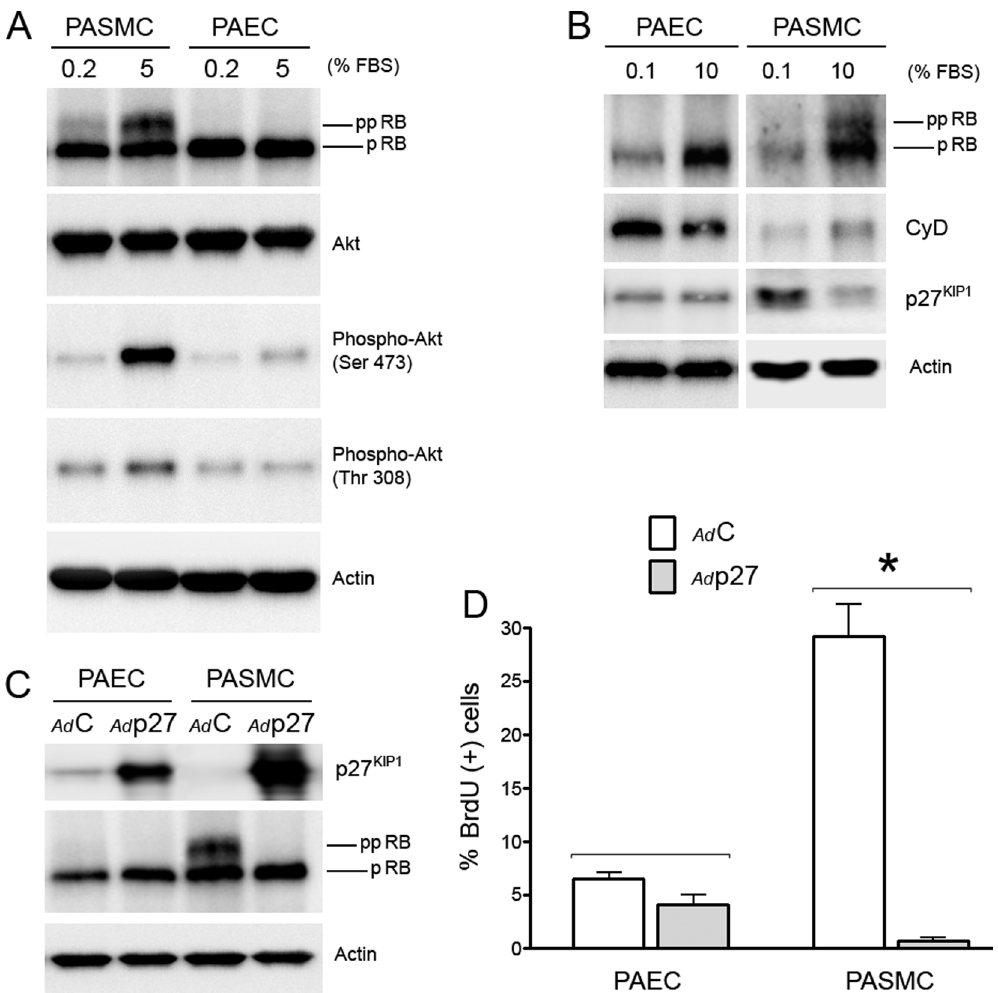
Figure 3. Increased serum phosphorylates retinoblastoma, Akt Ser473 , and AKT Thr308 and decreases p27 KIP1 in confluent PASMC, but not in confluent PAEC. A and B) Human PAEC and PASMC attained confluence in low (0.2%) serum and were maintained in low serum for seven days. Cells were then exposed to 0.2% or 5% serum and 24 hours later, cell lysates were harvested for protein analysis. Representative Western blots are shown. C) Human PAEC and PASMC attained confluence in low (0.2%) serum and were maintained in low serum for seven days. Cells were infected for 2 hours at a multiple of infectivity of 200 with a replication-deficient adenovirus serotype 5 containing either a human p27 KIP1 ( Ad p27) or alkaline phosphatase ( Ad C) cDNA driven by a CMV promoter. Cells were then exposed to 5% serum and cell lysates harvested 24 hours later. A representative Western blot is shown. [pRB: hypophosphorylated retinoblastoma; ppRB: hyperphosphorylated retinoblastoma]; D) BrdU incorporation 24 hours after exposure to 5% serum in p27 KIP1 -infected human PAEC and